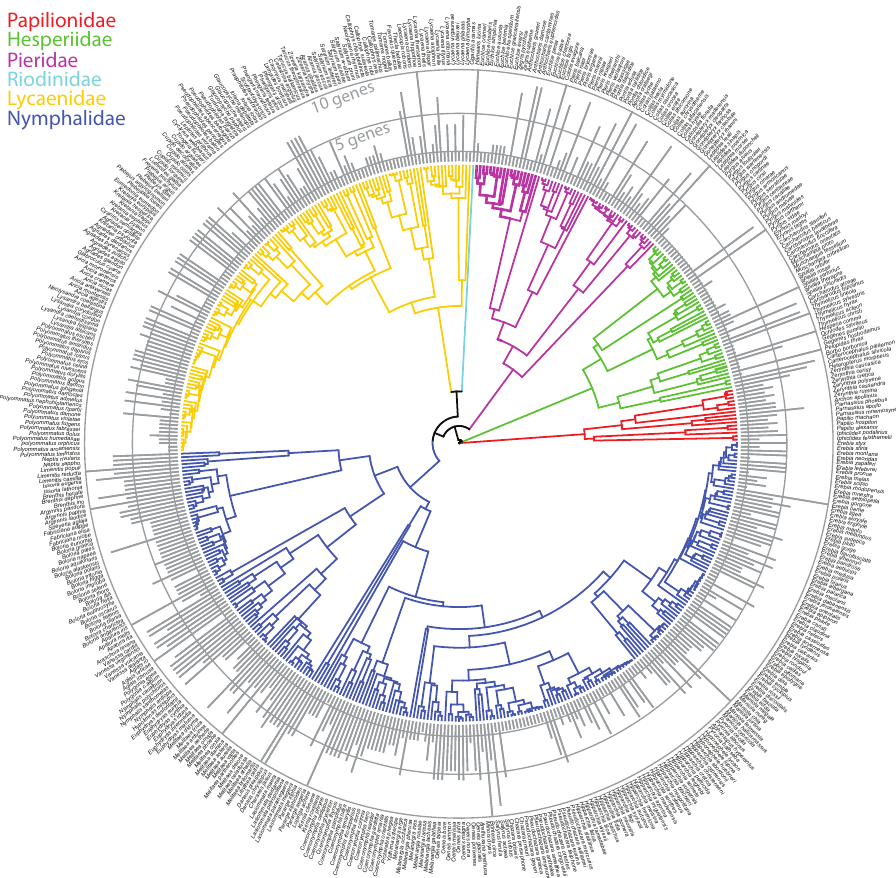
Figure 3. Time-calibrated tree of European butterflies. Grey bars indicate gene coverage per taxon. ration of macro-evolutionary processes into biodiversity analyses at macroecological, landscape and local community scales and by combining trait- and phylogeny-based assessments of species assembly